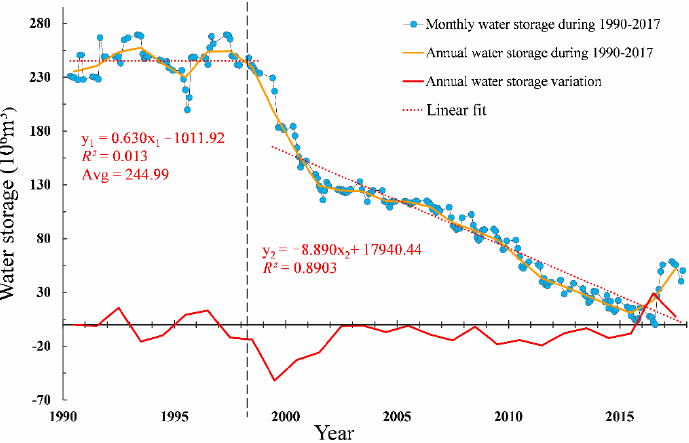
Figure 7. Changes in and trend of the lake level of HN during 1990–2017.